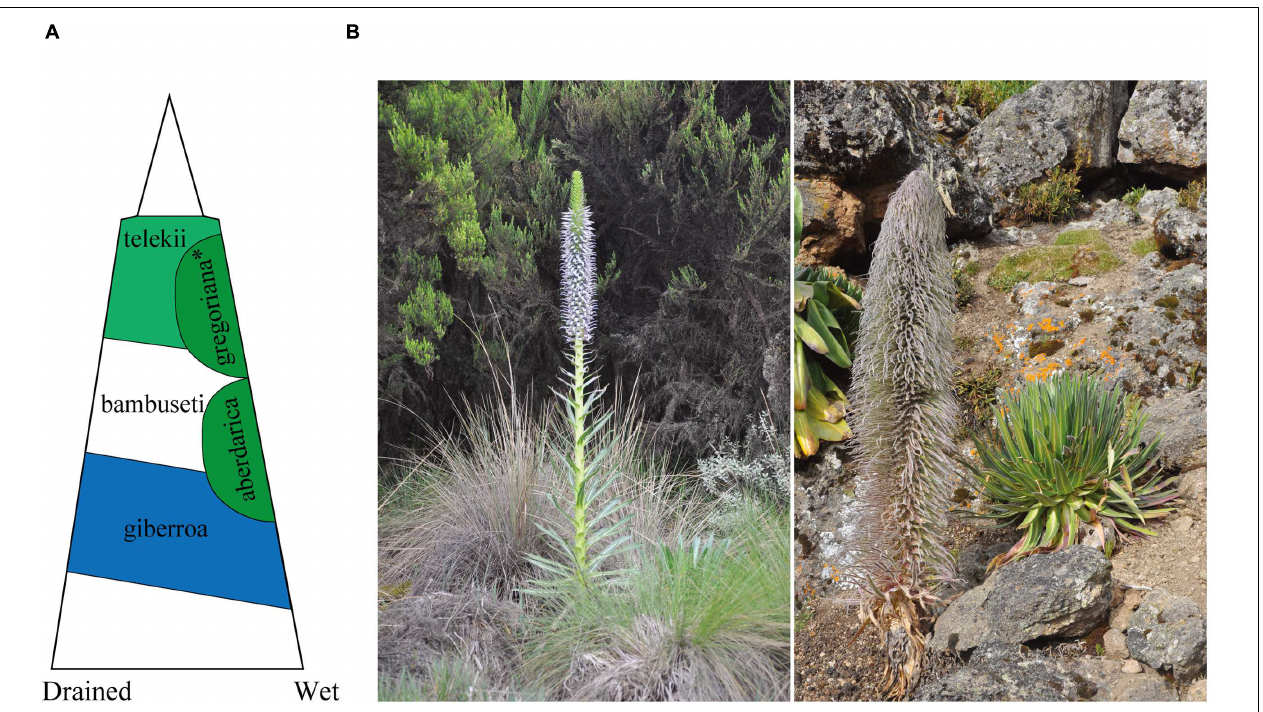
FIGURE 1 | Distribution and photos of giant lobelias. (A) Generalized distribution on Mt Kenya along altitude and moisture [modified from Knox and Palmer (1998)]. ∗ Lobelia gregoriana was treated as L. deckenii subsp. keniensis in Thulin (1984). (B) Lobelia aberdarica (left), photographed at Aberdare Mountains (Kenya), alt. c. 2800 m (photo: Ling-Yun Chen); L. telekii (right), photographed at Mt Kenya (Kenya), alt. c. 4200 m (photo: Ling-Yun Chen).